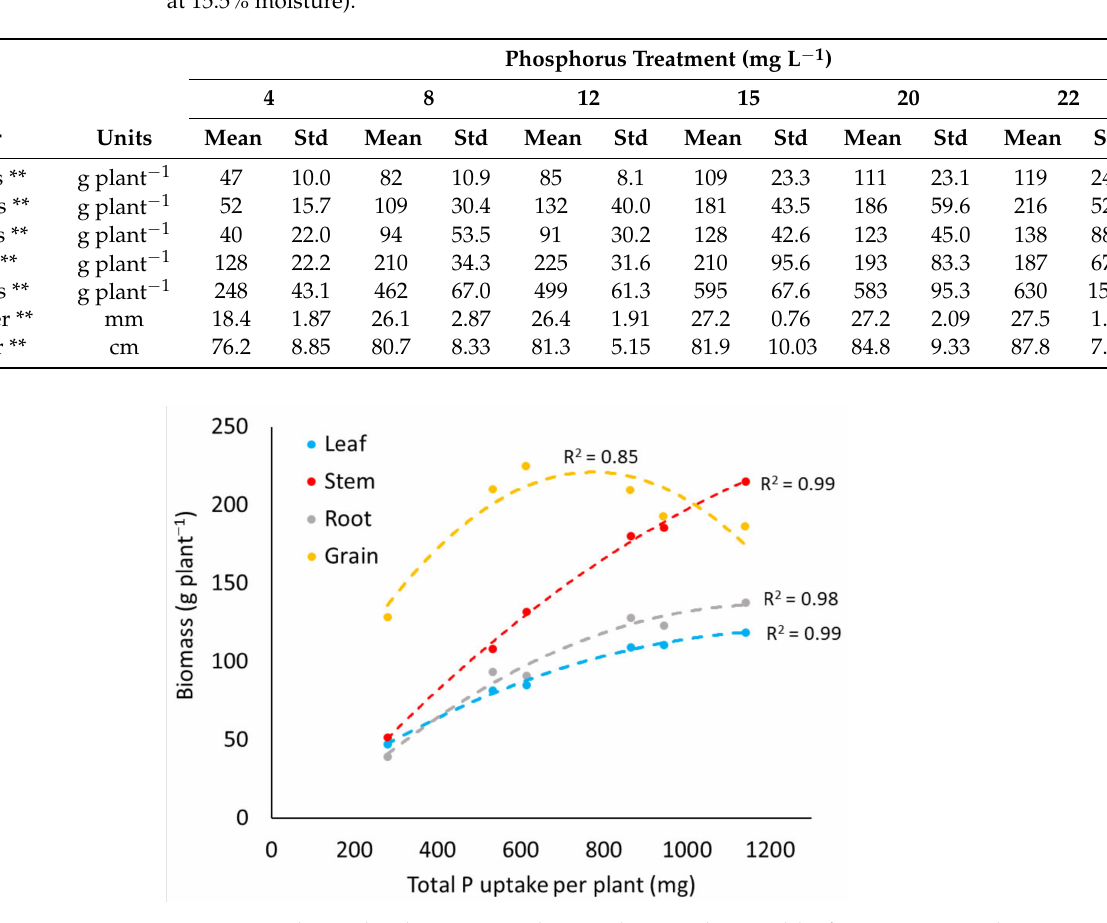
Figure 2. Relationship between total P uptake per plant and leaf, stem, root, and grain. “Stem” includes stem, cob, and tassel, and “Leaf” includes leaves and husk. Values averaged for each P treatment across hybrid. All mass presented on dry weight basis except for grain (15.5%